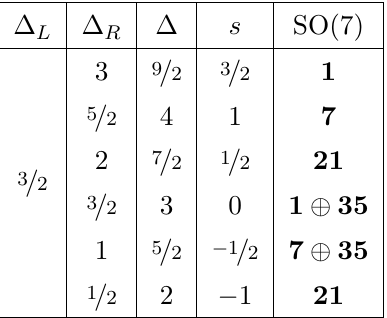
= (7 ; 0) supersymmetries. The N